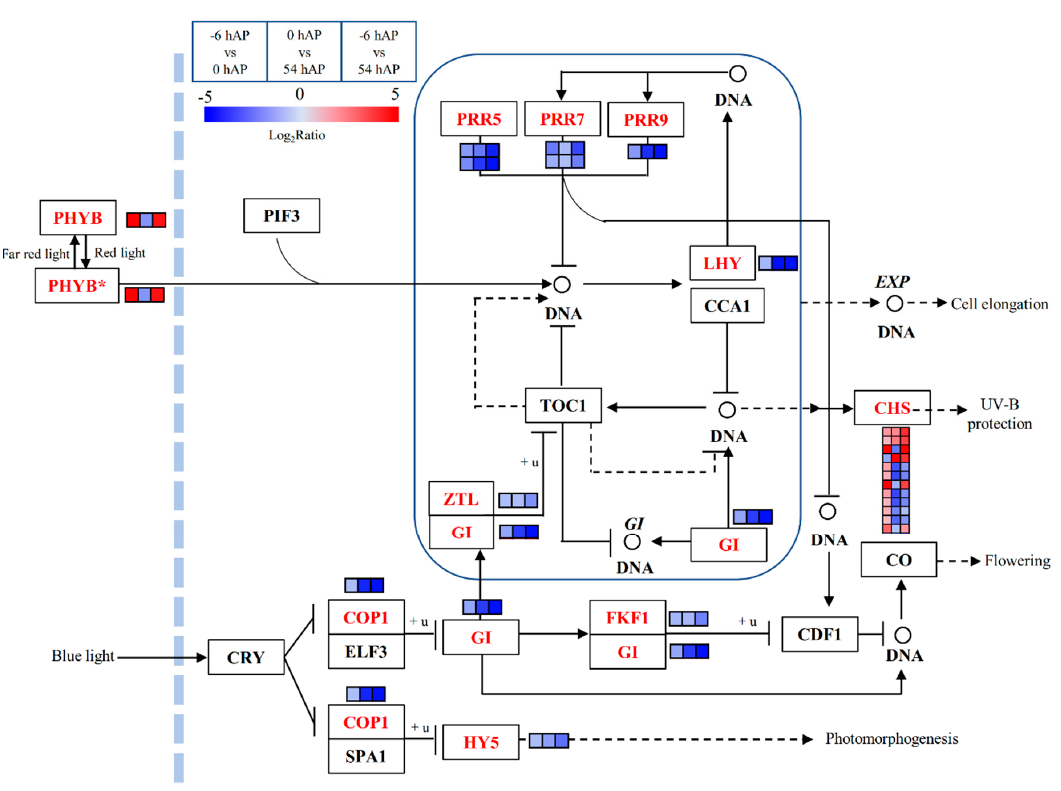
Figure 4. The significantly expressed common genes involved in the circadian rhythm plant pathway during the early phases of AR formation in mulberry stem hardwood cuttings. The enriched common genes are in red, and the changes of transcriptional expression levels in the three comparison groups are illustrated with colored boxes. The boxes from the left to right indicate − 6 hAP vs. 0 hAP, 0 hAP vs. 54 hAP, and − 6 hAP vs. 54 hAP, respectively. Each row of boxes represents a mulberry homolog gene. The color code from blue to red represents the changes of transcriptional expression level between –5 and 5. The solid or dashed arrows indicate direct or indirect positive effects, and the T type lines indicate inhibitory effects. This figure is redrawn based on the KEGG pathways.